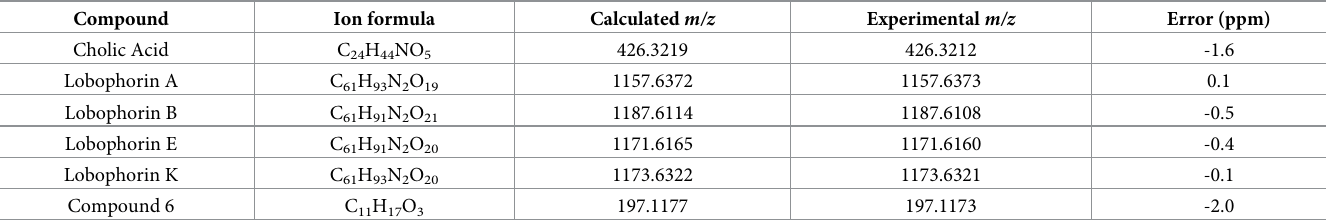
Table 6. MS data obtained for secondary metabolites detected in Streptomyces sp. MW562807 extract.